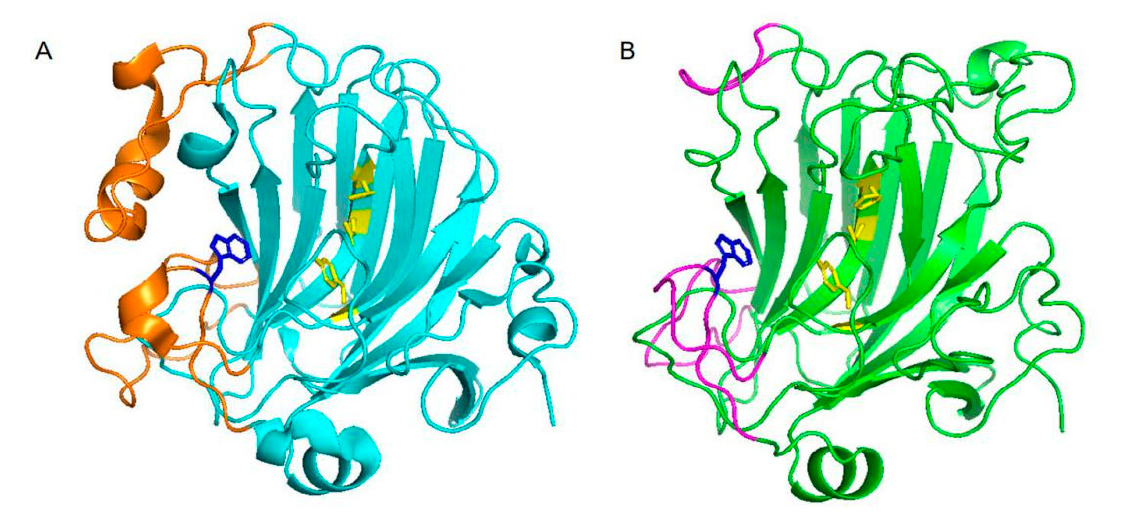
Figure 2. The three-dimensional structure of AlyA5 and VsAly7D. ( A ) The superimposition of the three-dimensional structure of AlyA5. Three loops of AlyA5 (orange cartoon) are highlighted. The catalytic sites of AlyA5 are shown in yellow, and Trp 313 is shown in blue. ( B ) The superimposition of the three-dimensional structure of VsAly7D. The three loops of VsAly7D (magenta cartoon) are highlighted. The catalytic sites of VsAly7D are shown in yellow, and Trp 315 is shown in blue.